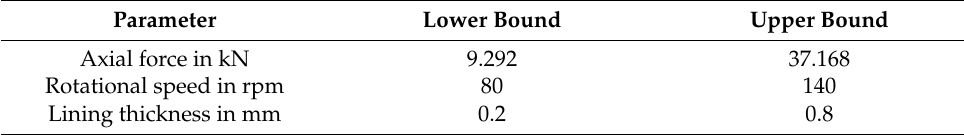
Figure 5. Temperature distribution of the clutch at ( a ) 0 s, ( b ) 14 s, ( c ) 28 s. For the generation of the datasets, 200 simulations were run per use case. A Latin hypercube sampling was employed for the sampling of the parameter combinations. The lower and upper bounds of the individual parameters are shown in Table 2. Each simulation yields a tuple ( p i , T i ), where p i ∈ R m is an m -dimensional vector representing the m varied parameters of the respective use case ( m = 2 for Use Case 1 and m = 3 for Use Case 2) and T i ∈ R 29 is a vector with the maximum temperature T max at the each of the 29 timesteps (see Table 3). Table 2. Boundaries of the varied input parameters.